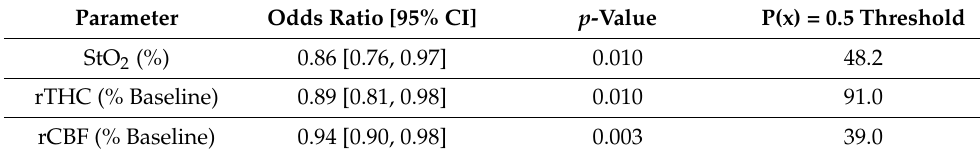
Table 2. Odds Ratios and Thresholds for Cerebral Hemodynamic Prediction of LPR >40.